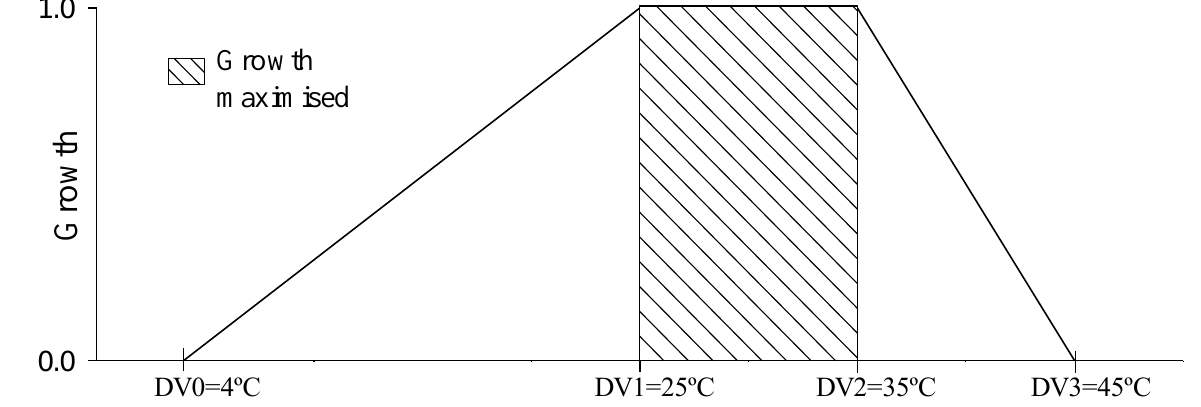
Figure 1. Temperature as a function of population growth. Parameters used to define suitable temperature ranges for U. panicoides population growth. DV0: limiting low temperature, DV1: lower optimal temperature, DV2: upper optimal temperature, and DV3: limiting high temperature.